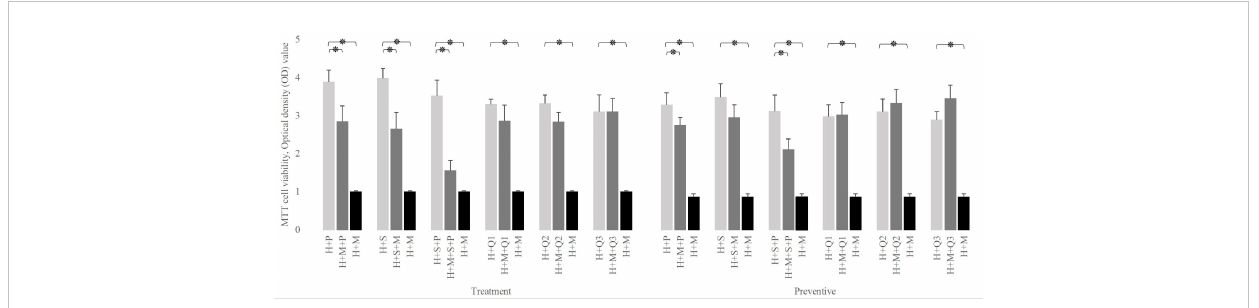
FIGURE 3 Comparison of H (HEp-2 cell) viability in the presence of P ( L. plantarum ), S ( L. salivarius ), and M ( S. mutans) to the absence of one of them. The simulation ’ s presence of any doses of Q10 or L . salivarius preserves the viability of HEp-2 cells in both therapeutic and preventive settings. The values are the mean ± SD of these assays. Asterisk (*) indicates a signi fi cant difference (p-value<0.05) in the values when compared to the